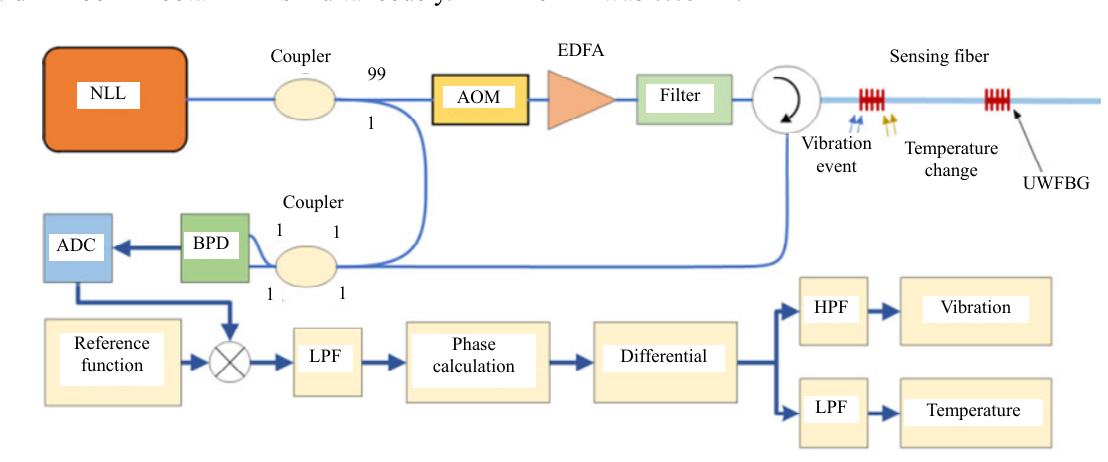
Fig. 16 System configuration of the simultaneous distributed temperature and vibration sensor [59]